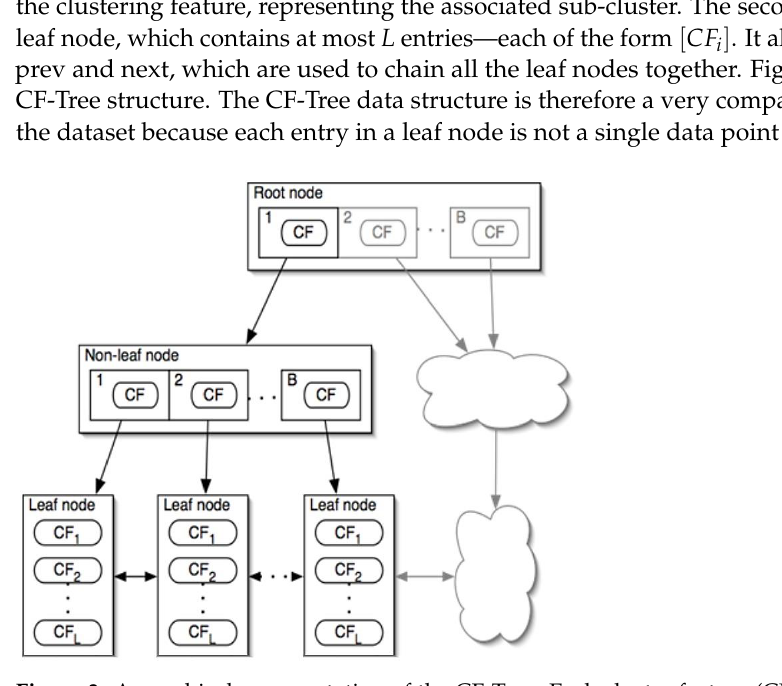
Figure 3. A graphical representation of the CF-Tree. Each cluster feature (CF) record represents a cluster or a sub-cluster of